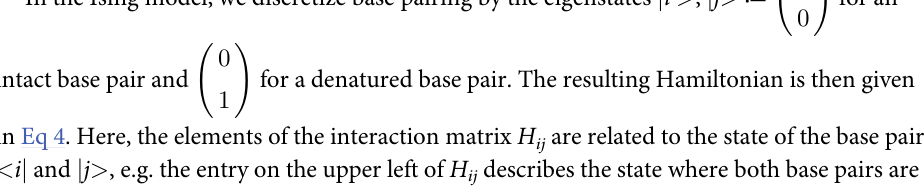
Table 3. Stacking energies of the ten different base pair steps used in the Ising model. For base pairing we used E bp = 0.64 and E = 0.12 for AT and GC pairs, respectively. All values have been adapted from [49] and are in units of bp kcal/mol. ag ac at aa ta E stack